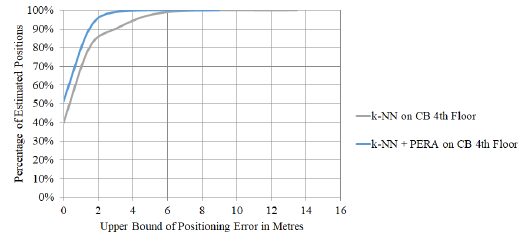
Figure 8. Cumulative Positioning Error on 4 th Floor of CB We see similar accuracy within the Chemistry building, position- ing error less than 3 metres 90% of the time for k -NN and po- sitioning error less than 2 metres 95% of the time for k -NN + PERA. Chemistry building is much newer than the PSE build- ing, but has similar sized hallways and likely relatively similar structural materials and access point distribution.